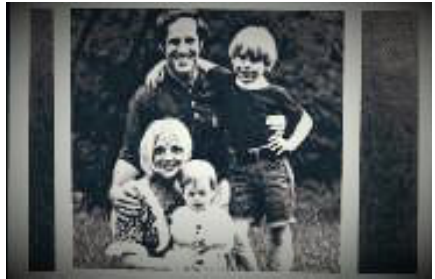
Figure A1. Goffman’s picture, man and son, woman and daughter.